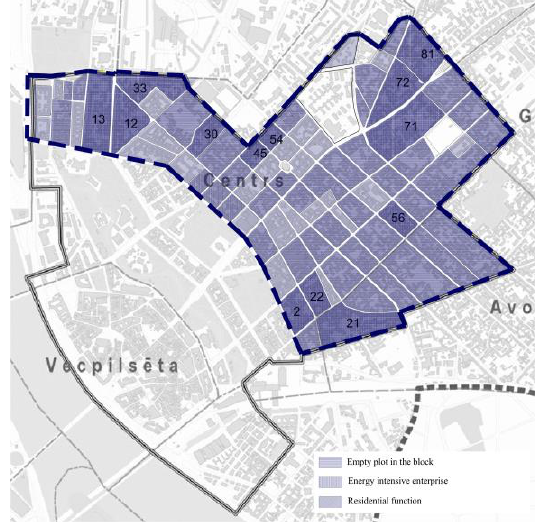
Fig. 7. Shortlisted “Energy